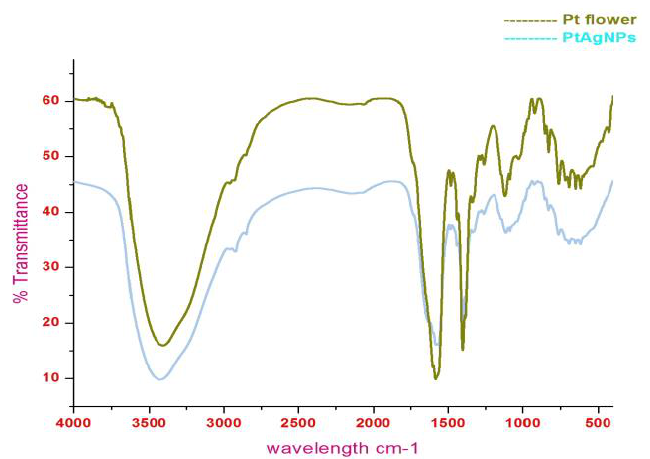
Figure 3. FTIR spectrum of the PTAgNPs and P. tuberosa flower extract (powder).